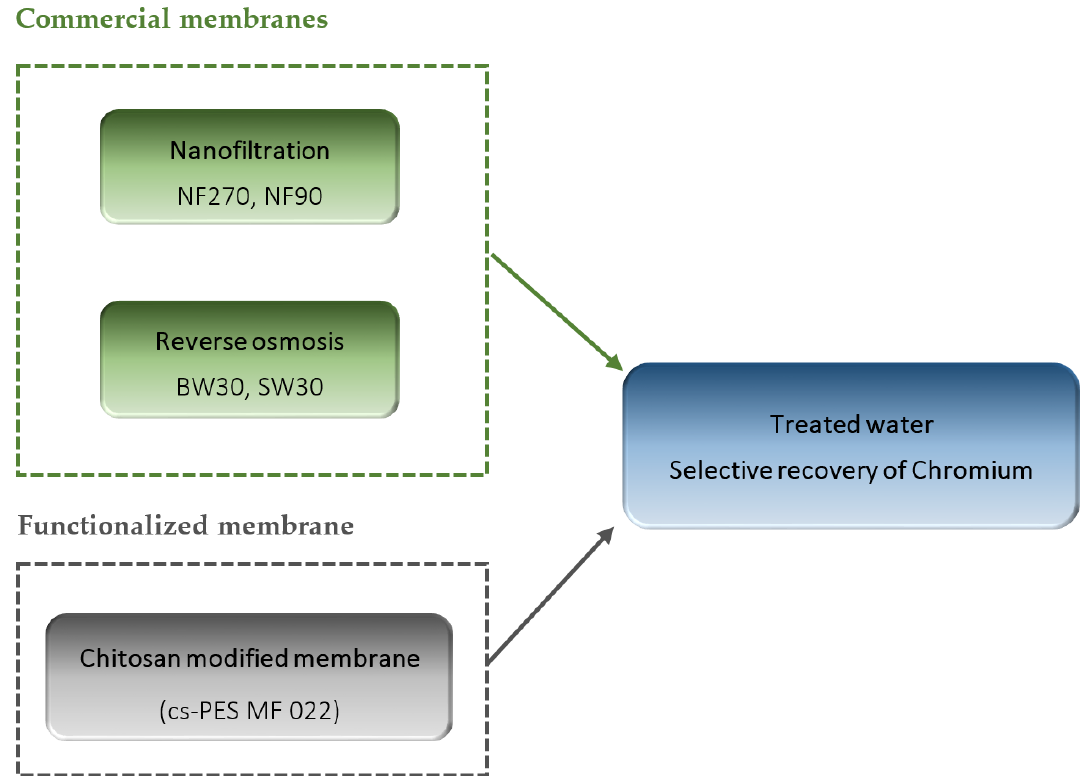
Scheme 1. Diagram showing the experimental work plan and final goals.